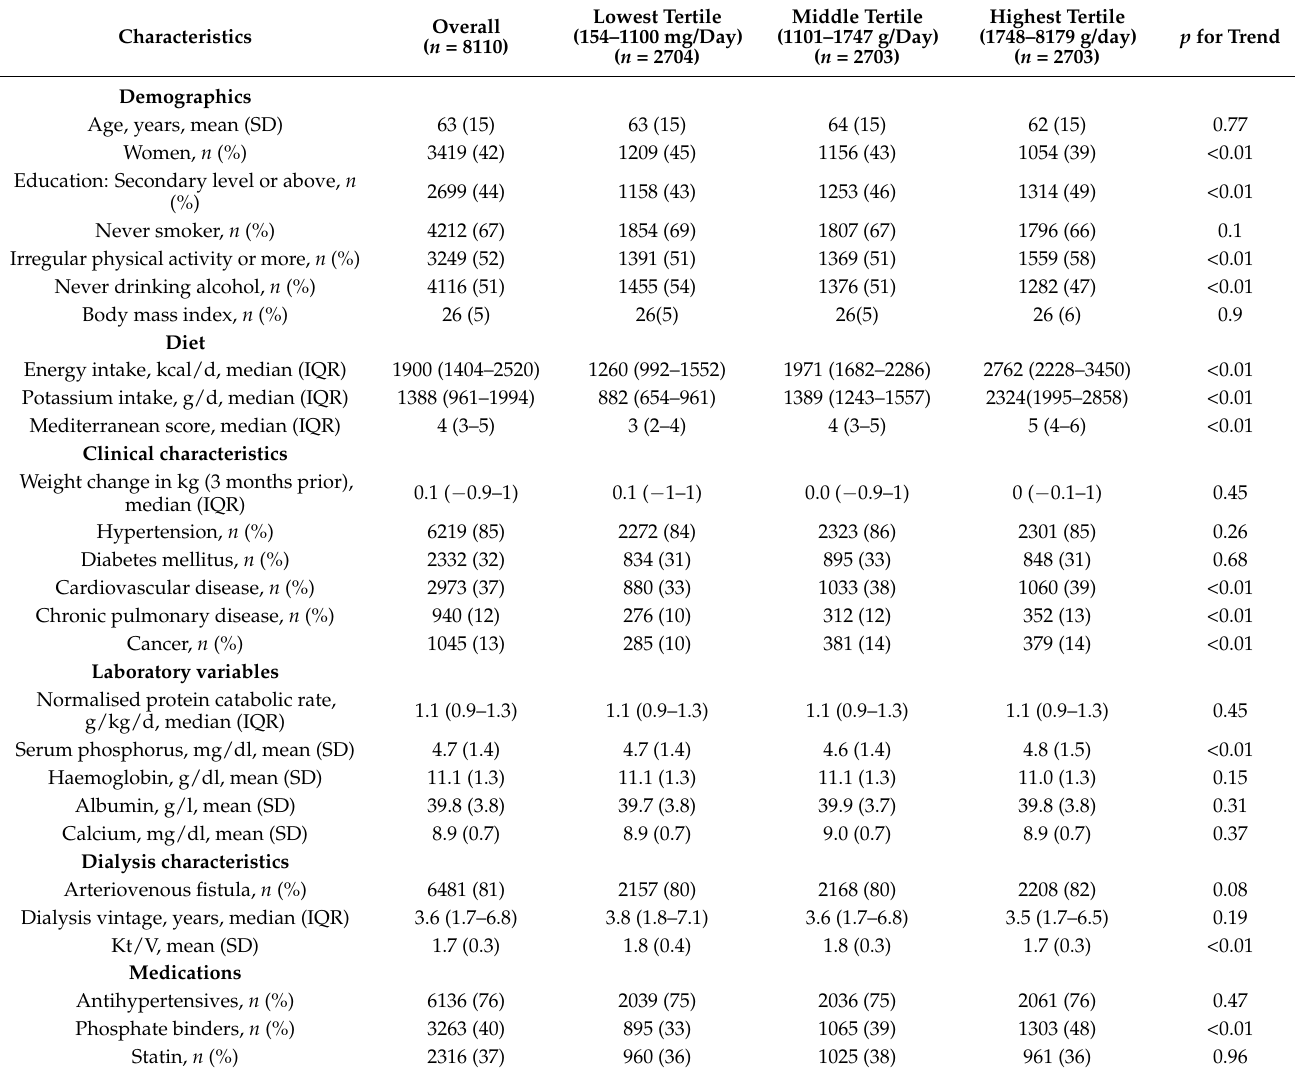
Table 1. The baseline characteristics, overall, and by tertiles of the daily phosphorus